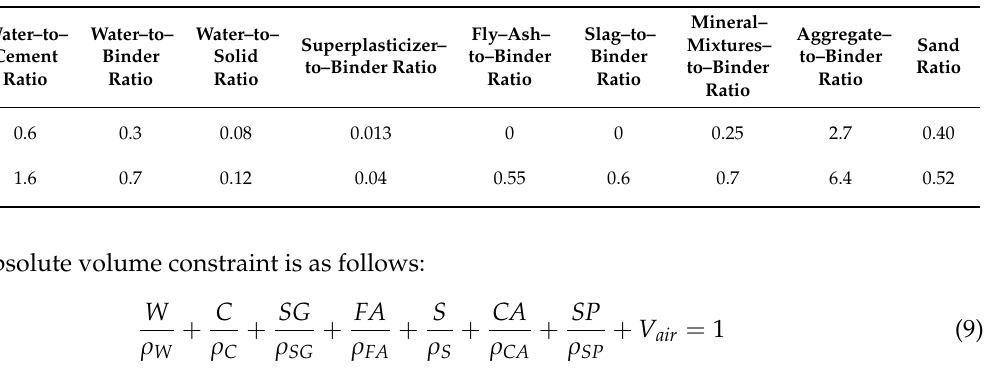
Table 3. The component ratio constraint